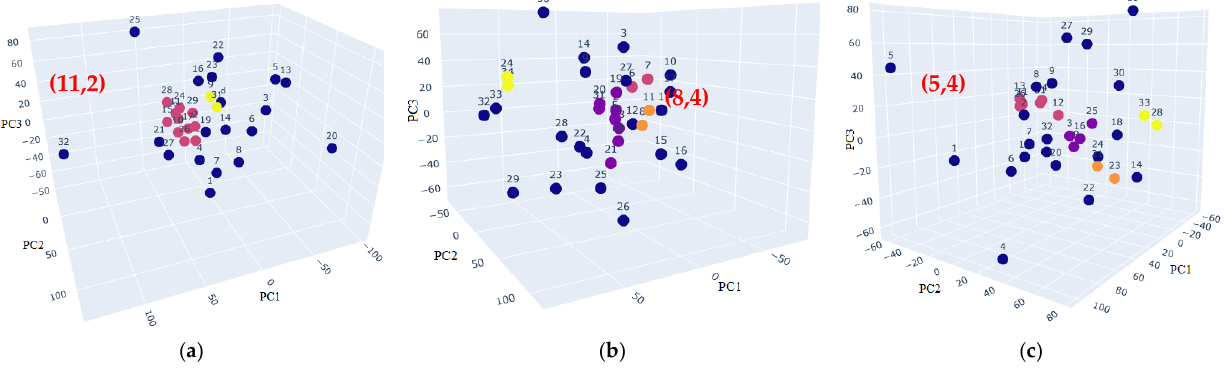
Figure 8. PCA clustering arranged according to the maximum points in their clusters identified by DBSCAN for Cu from tighter ( a ) to wider ( c ): ( a ) P Med -Copper; ( b ) P Min -Copper; and ( c ) P Max -Copper where PC1: first principal component; PC2: second principal component; and PC3: third principal component of PCA analysis. The different colored dots (yellow, orange and purple) regarding founded clusters by DBSCAN and the numbers in red: (Maximum points in clusters, number of clusters) of these clusters.